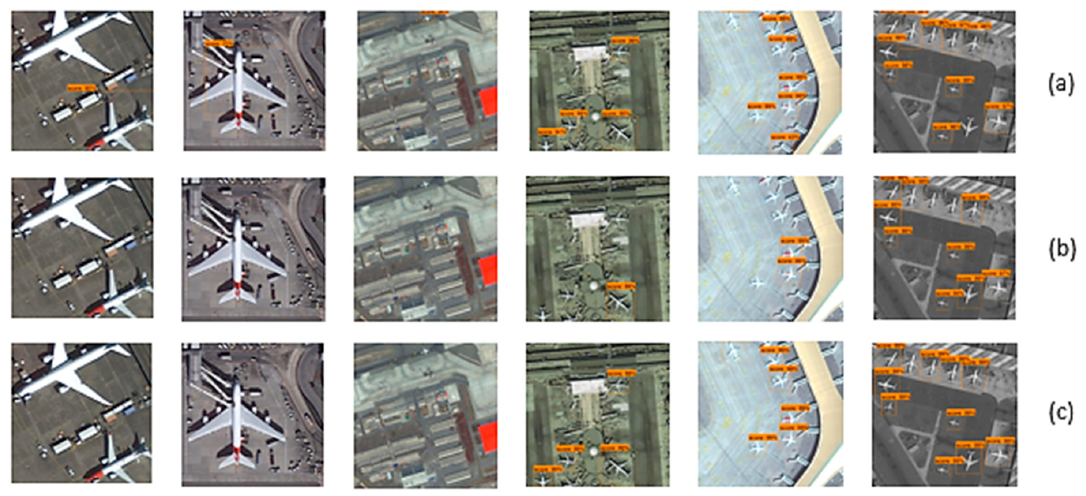
Figure 12. Detection results of some of the DOTA test set patches ( a ) Yolo-v3, ( b ) SSD, ( c ) Faster R-